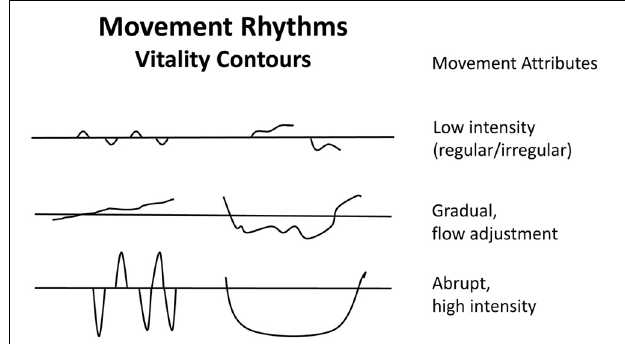
FIGURE 3 | Movement rhythms. Example of rhythm writing to capture affect expression and vitality contours (Kestenberg and Sossin, 1973, 1979; Stern,